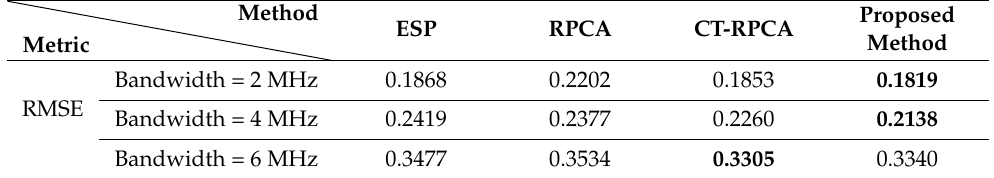
Proposed Method